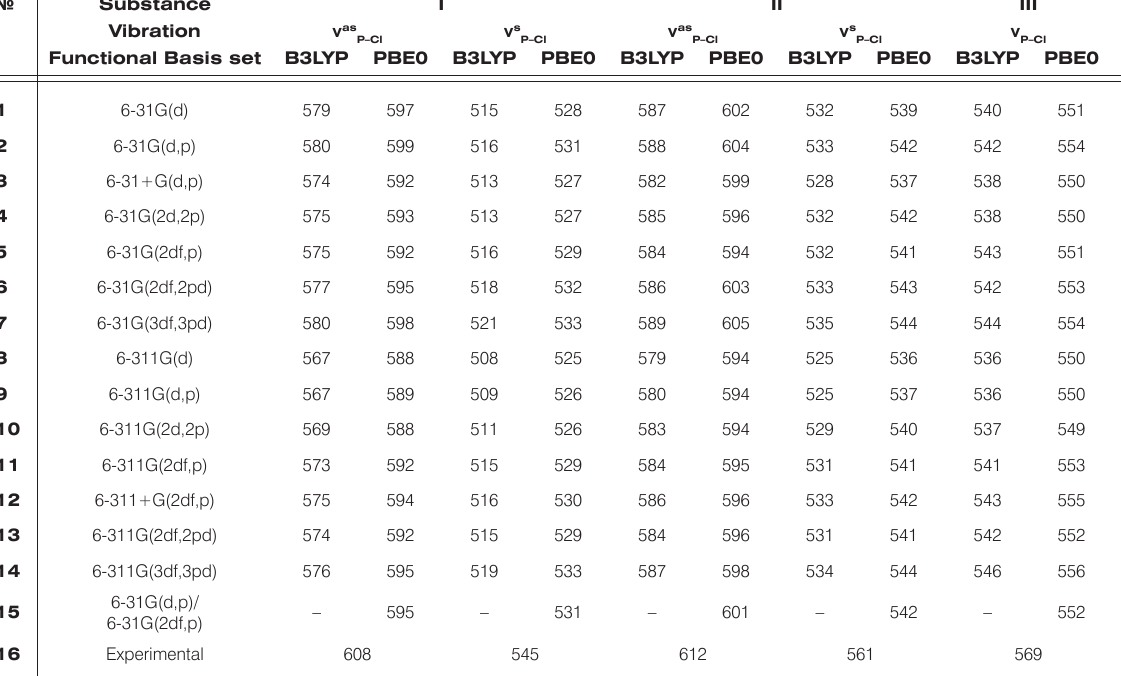
Table 7. Frequencies of P–Cl stretching vibrations (cm -1